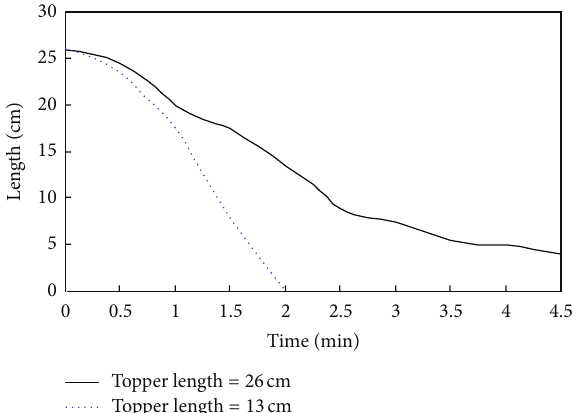
Figure12:Evolutionofthetoplengthofalandslidedamfordifferent sized